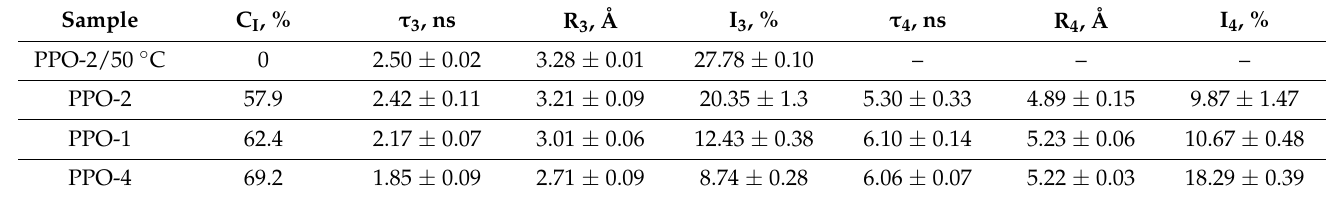
Table 3. Parameters of spectra of ortho-positronium lifetime in samples (PALS